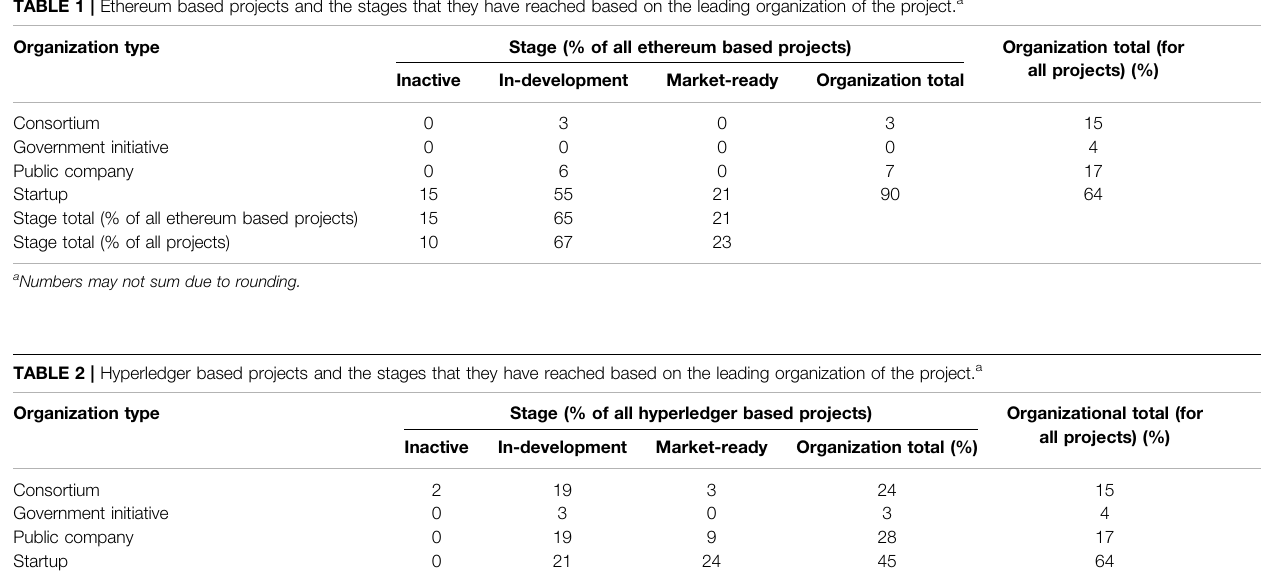
TABLE 1 | Ethereum based projects and the stages that they have reached based on the leading organization of the project. a